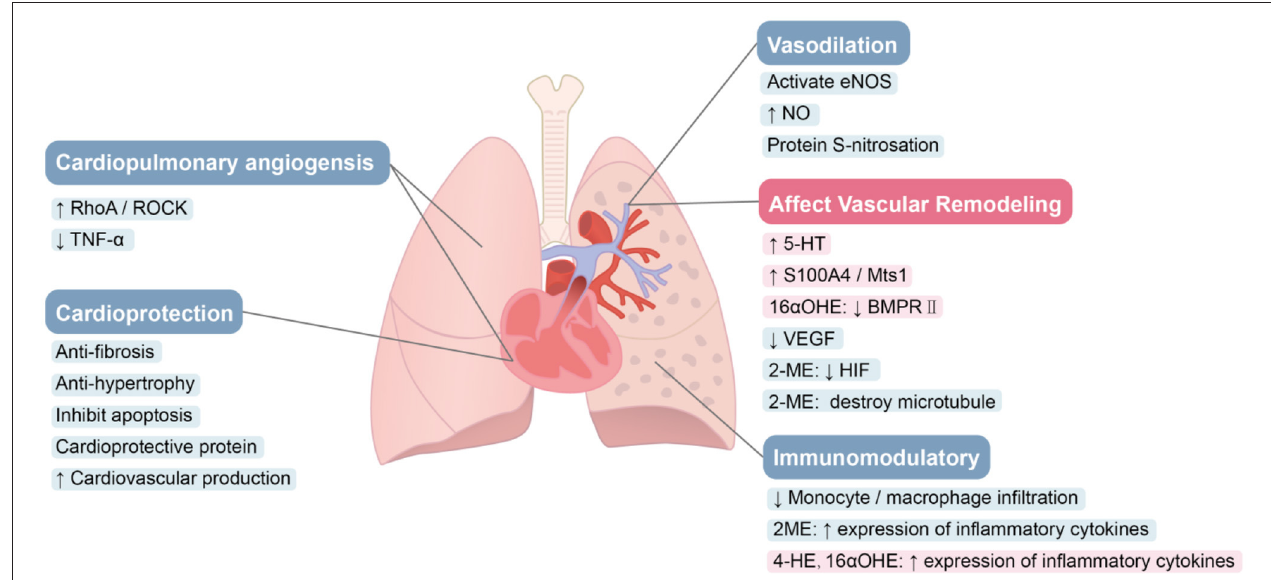
FIGURE 3 | Role of estrogen and its metabolites in PAH. E2 protects the heart through various pathways. Estrogen can promote blood vessel remodeling. E2 improves cardiac structure and function via augmentation of angiogenesis. Estrogen can improve pulmonary hemodynamics. Estrogen and 2-ME appear to suppress inflammation in PAH, while 4-OHE and 16 α -OHE1 have significant pro-inflammatory